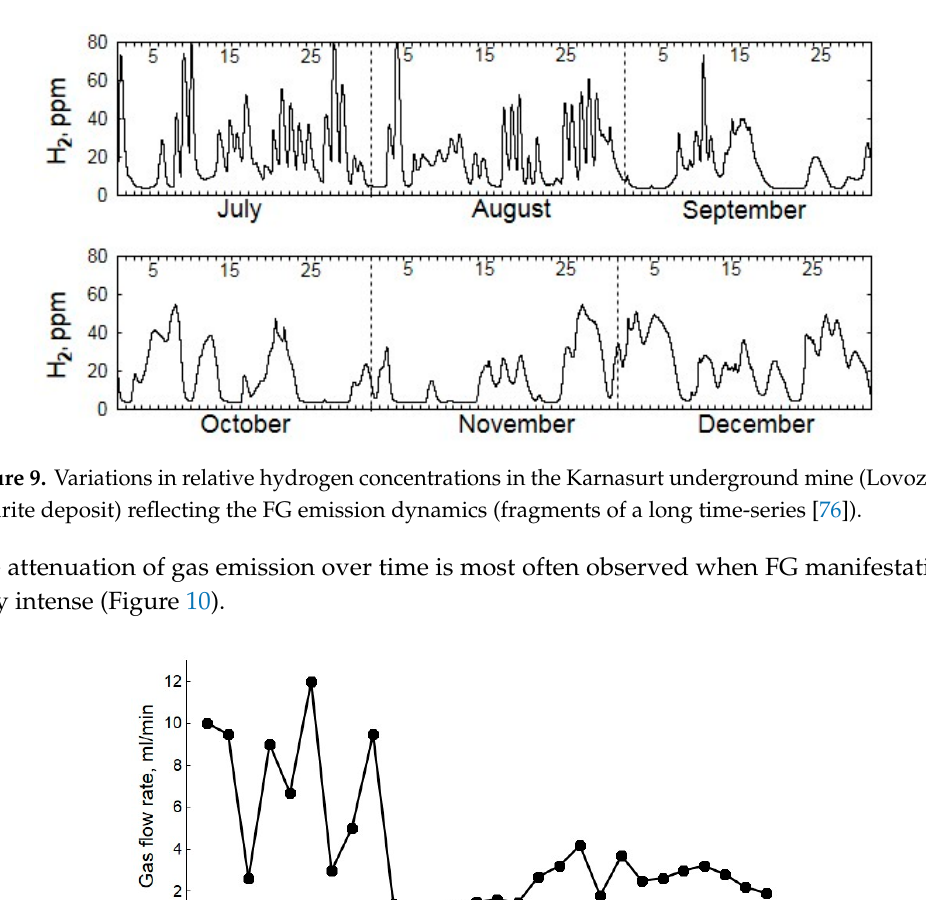
Figure 8. Generalized pattern of FG release into sealed shot-holes in response to blasting (from [88], with modifications). Gas discharges were recorded in 12 cases using a rotameter. The conventional moment of blasting at a distant section of the mine is shown under the horizontal axis at an arbitrary time. C.u.—conventional units.